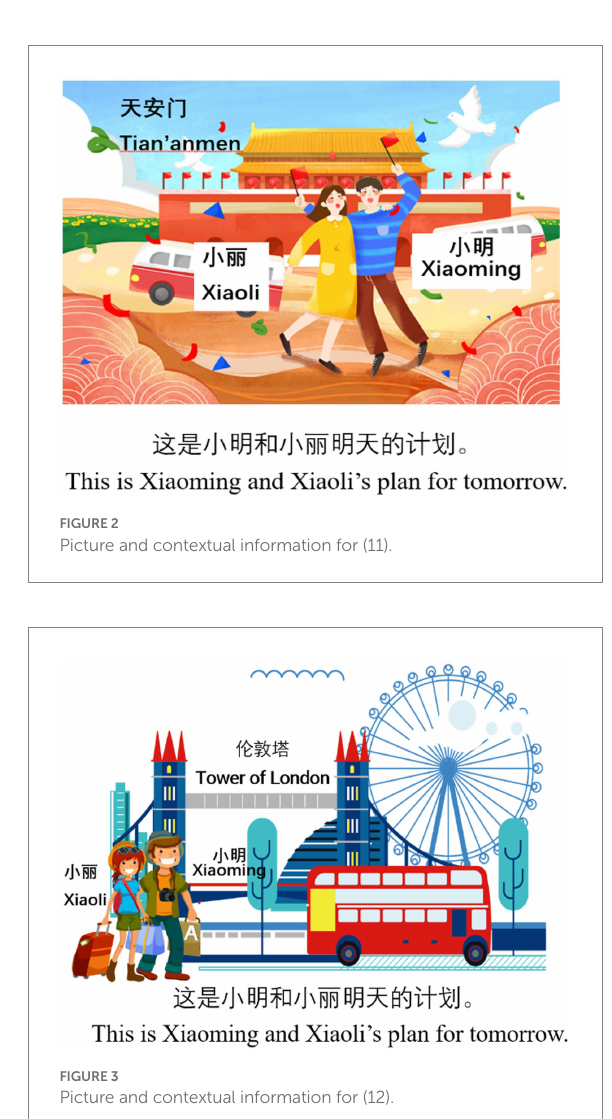
FIGURE 3 Picture and contextual information for